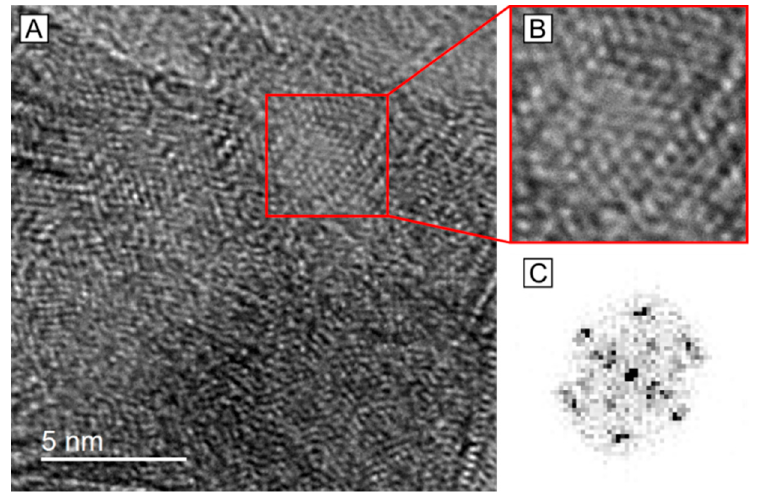
Figure 4. High-resolution transmission electron microscopy (HRTEM) image of sample MoS 3.4 showing the in-plane ordering. ( A ): Overview of the edge of a particle; ( B ): zoom in the area marked with a red square in A; ( C ): Fast Fourier Transformation (FFT) of the area shown in B.